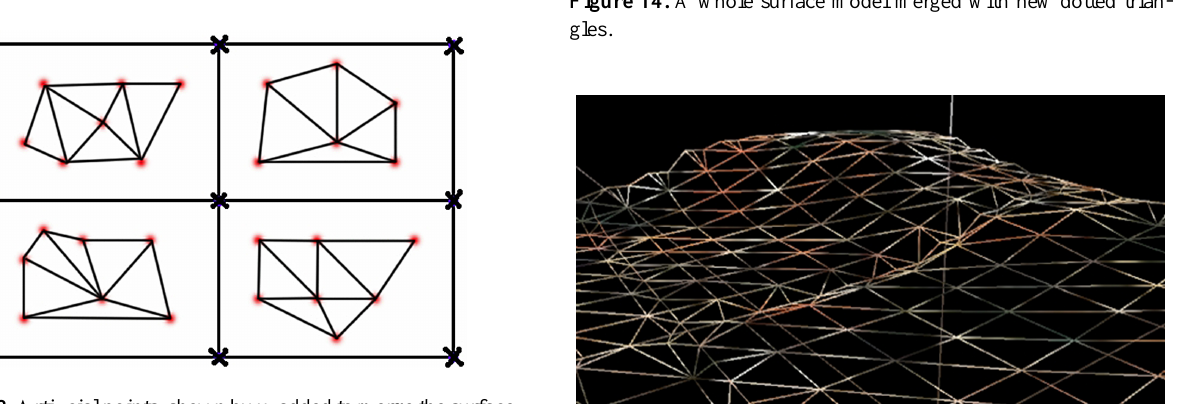
Figure 12. Surfaces of polyhedrons.